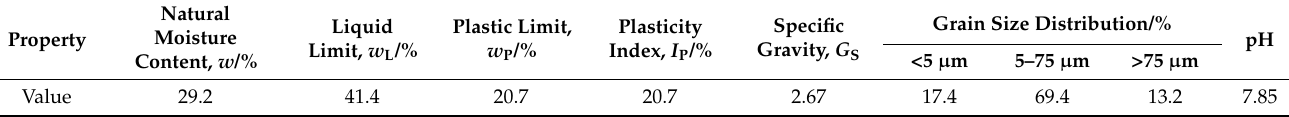
Table 1. Physico-chemical properties of soil.